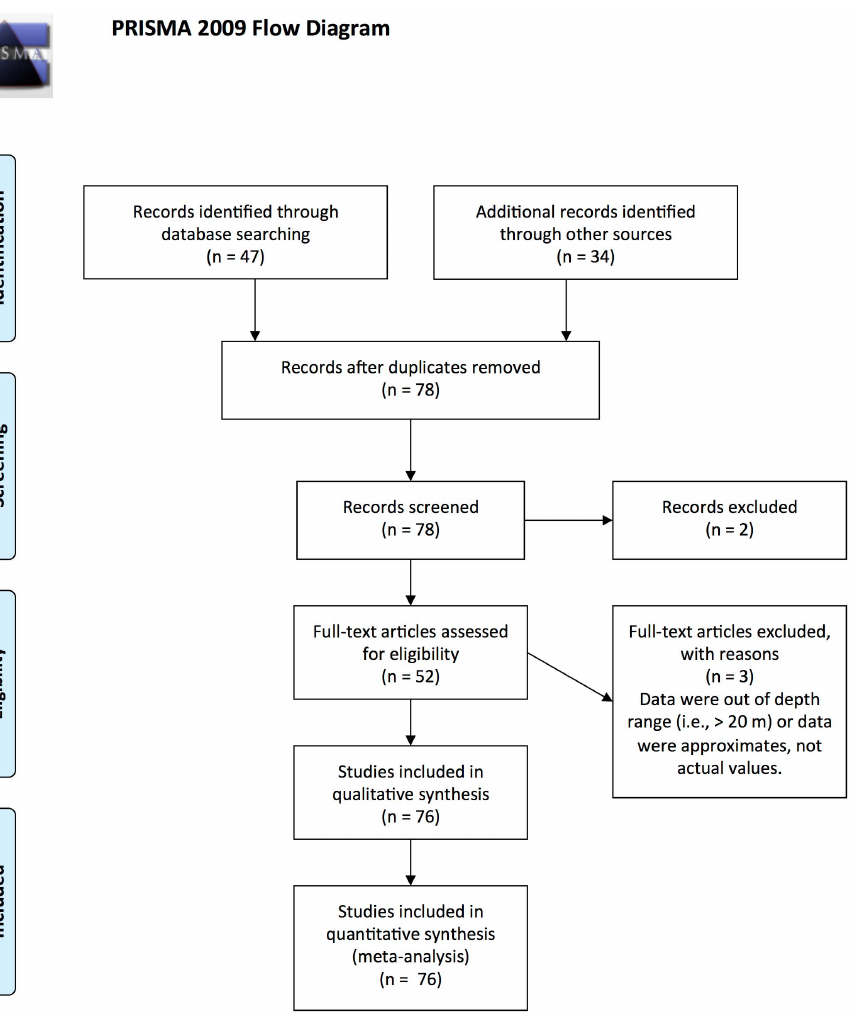
Figure 1. Literature identification and filtering for inclusion in meta-analysis of coral cover patterns in Western Australia.